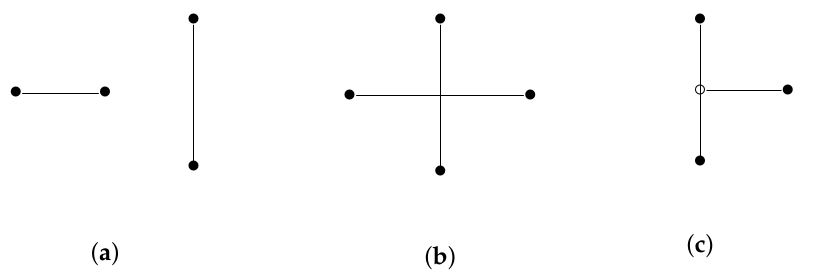
Figure 2. Two line segments whose explicit topology does not allow common points: ( a ) topologically consistent; ( b ) topologically inconsistent line–line intersection; ( c ) topologically inconsistent point– line intersection. Case ( b ) is missing the intersection point. Both lines should explicitly reference the intersection point within their definition. Case ( c ) misses the intersection point explicitly referenced by the vertical